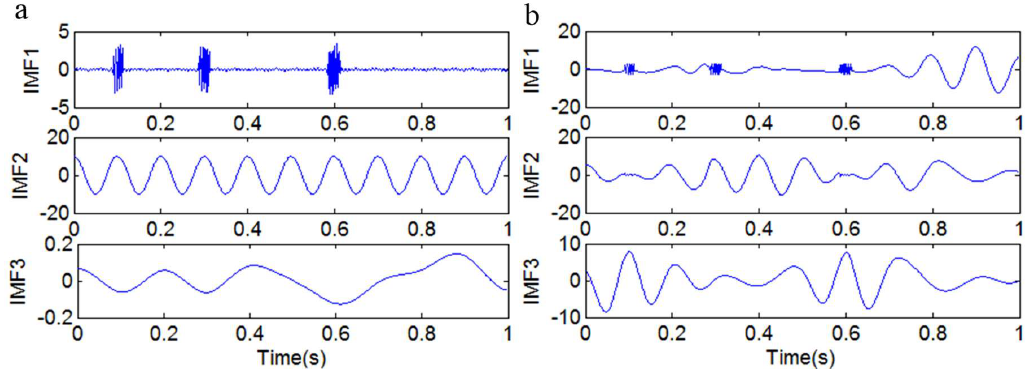
Figure 14. The first three IMFs. ( a ) The IMFs obtained by adding the sinusoidal signal y 9 ( t ); ( b ) the IMFs obtained by the original EMD method.